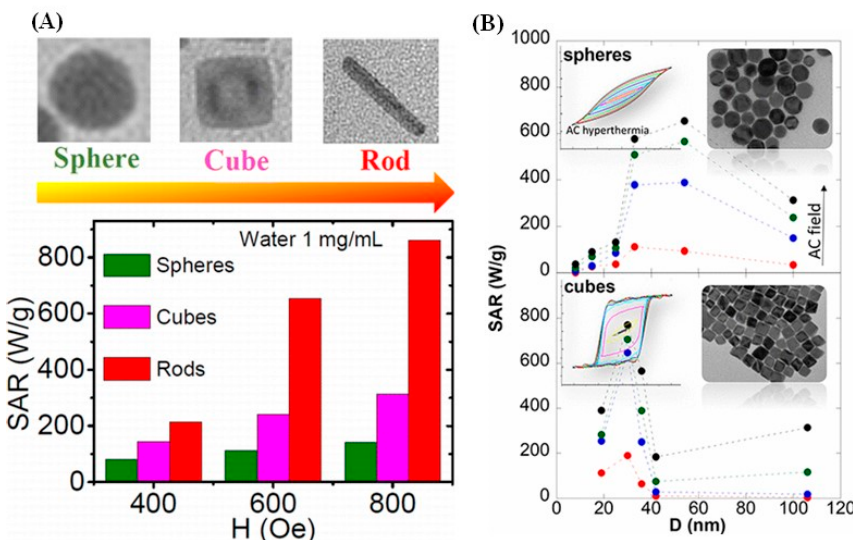
Figure 13. ( A ) SAR vs. field plot for the Fe 3 O 4 spheres, cubes, and nanorods of nearly the same volume ( ∼ 2000 nm 3 ) [89]. ( B ) SAR vs. size curves for the sphere and cube-shaped NPs measured in water (1 mg / mL) under AC magnetic fields of 0–800 Oe and at frequency of 300 kHz [118].